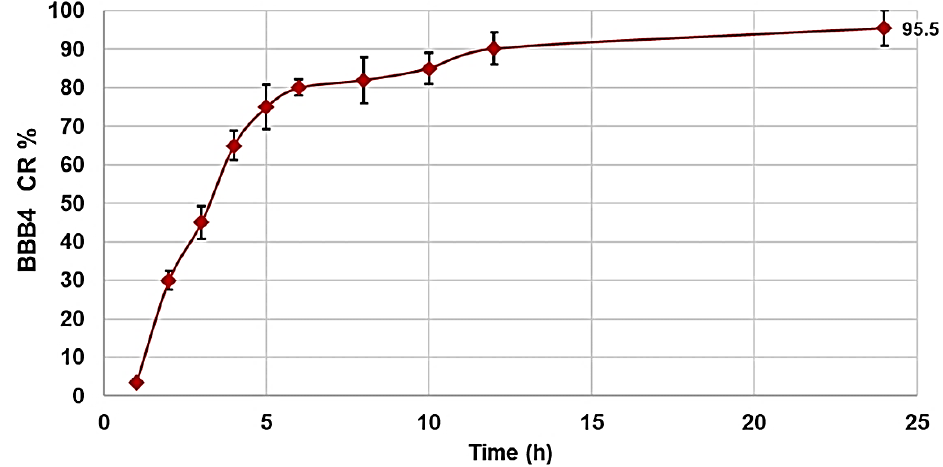
Figure 11. BBB4 CR% at pH 7.4 monitored for 24 h.